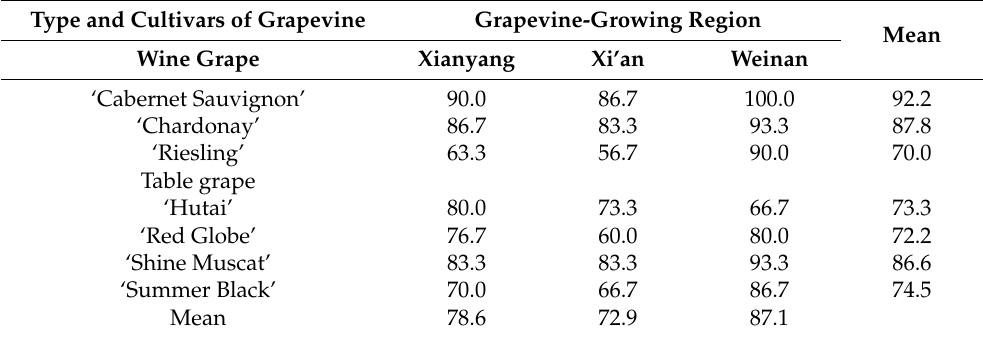
Table 1. Infection frequencies (%) of GLRaV-3, analyzed by RT-PCR in the three major grapevine- growing regions in Shaanxi province of China.